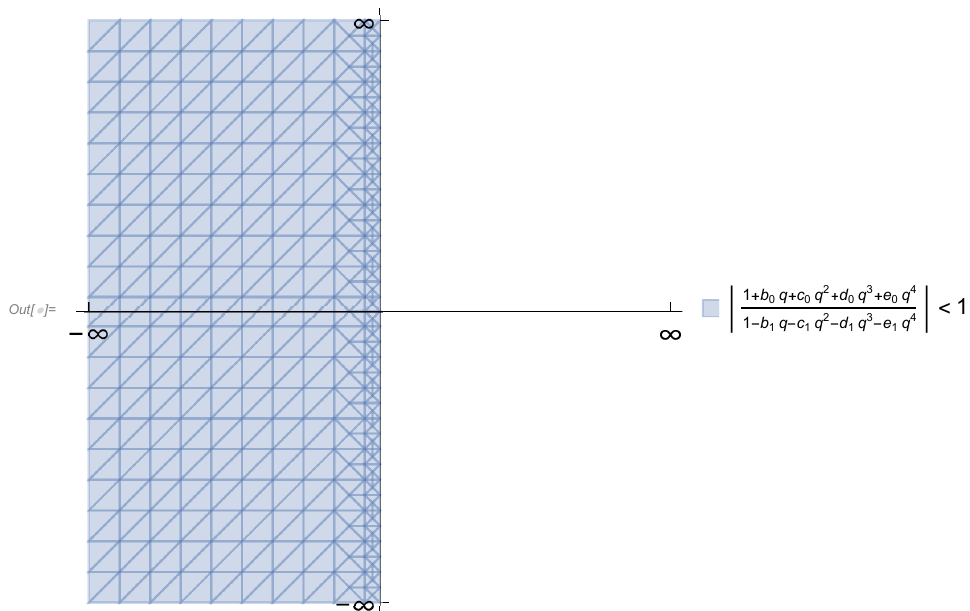
Figure 1. Region of absolute stability for the constructed methods